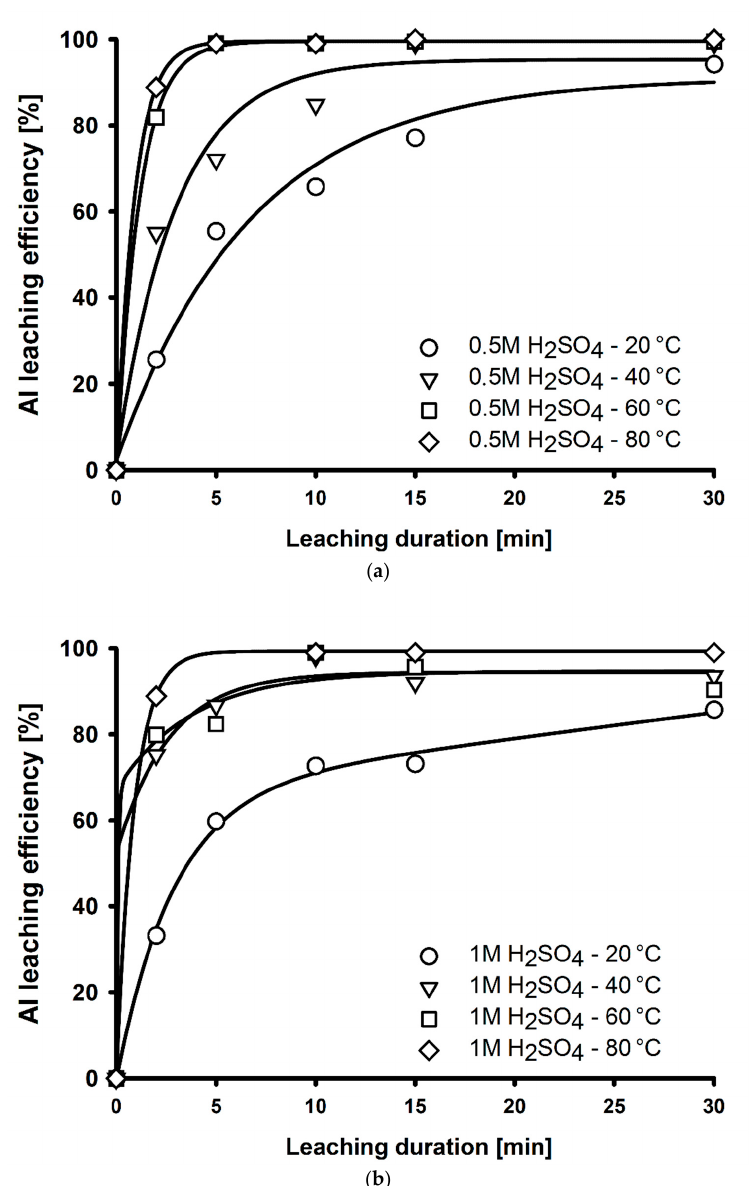
Figure 8. Aluminum leaching efficiency at 20–80 °C in 0.5 M ( a ) and 1 M ( b ) H 2 SO 4 . The apparent activation energy E a of lithium was determined from measured